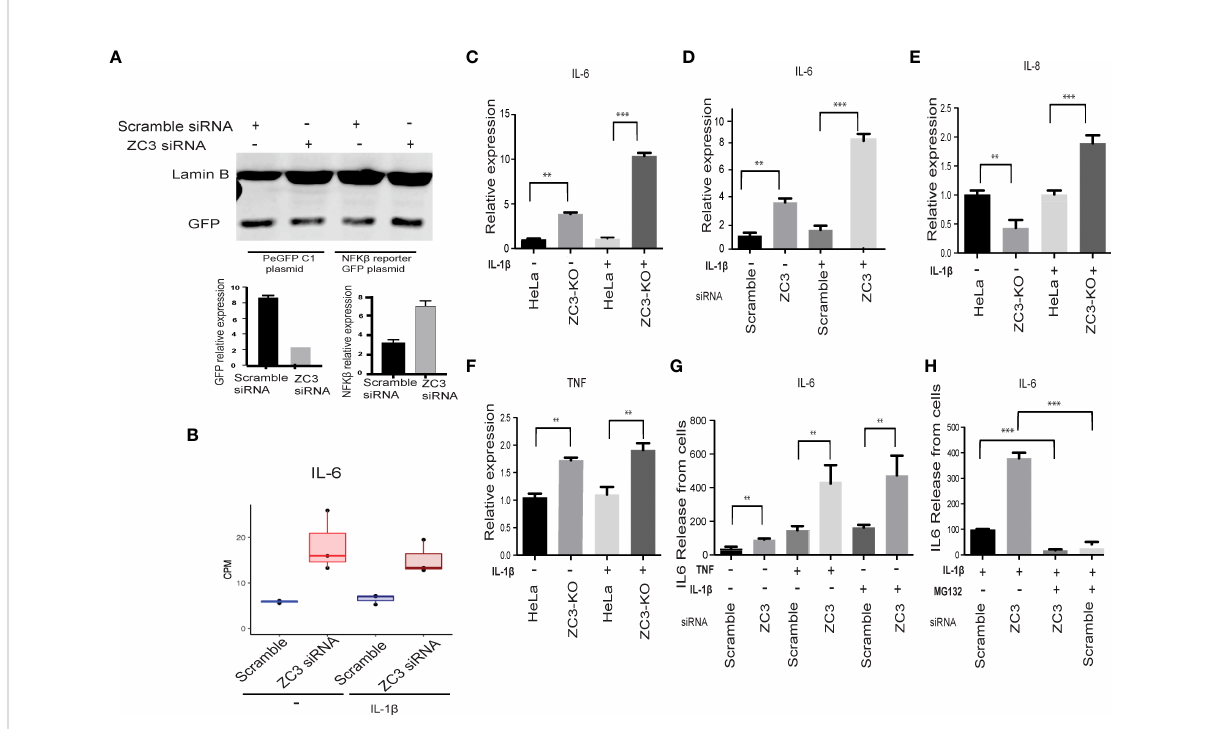
FIGURE 2 ZC3H11A negatively regulates NF- k B signaling. A GFP reporter contains a minimal NF-kB responsive promoter transfected to HeLa treated with scramble or ZC3 siRN. The expression of GFP from the GFP control plasmid and the GFP- NF-kB responsive promoter plasmid was visualized by western blot (A) . Expression of IL-6 mRNA in RNA seq normalized to GAPDH (B) . ZC3-KO or HeLa wild type cells transiently transfected with siRNAs were treated with IL-1ß (10 pg/ mL) for 1h. Total cytoplasmic RNA was isolated for RT-qPCR analysis of relative expression of IL-6 in treated or untreated ZC3-KO and HeLa wild type cells (C) or ZC3-KD and scrambled siRNA transfected cells (D) . Relative expression of IL-8 (E) and TNF were also quantitated in the ZC3-KO cells (F) . The release of IL-6 into the supernatant of HeLa cells transfected with a ZC3H11A or a scrambled siRNA was measured by an ELISA assay after 1 h of IL-1ß (10 pg/ mL or TNF (10 ng/ mL) treatment. (G) . Pretreatment of cells with MG132 (5 µM) for 3 hrs before IL-1ß stimulation blocked NF- k B signaling and IL6 release (H) . Data representative of three individual experiments with n = 3 technical replicates per treatment. **p < 0.01, ***p < 0.001, as determined by ordinary one-way Anova. All error bars represent ±